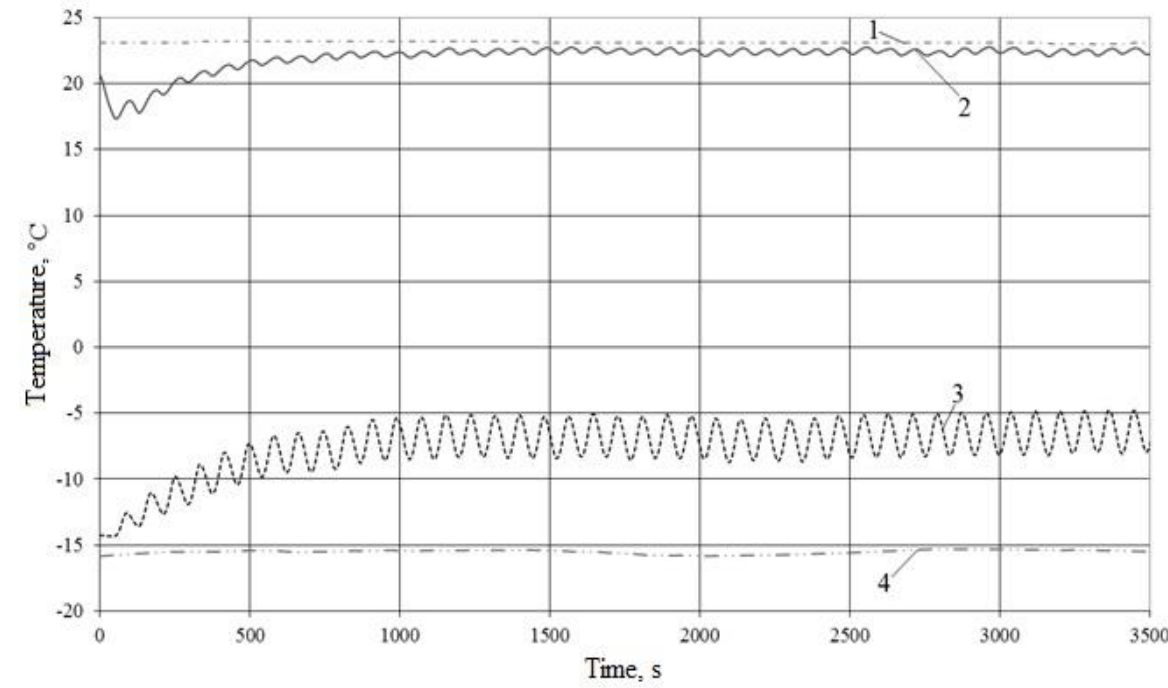
in ; 2: T a1 ; 3: T a2 ; 4: T out